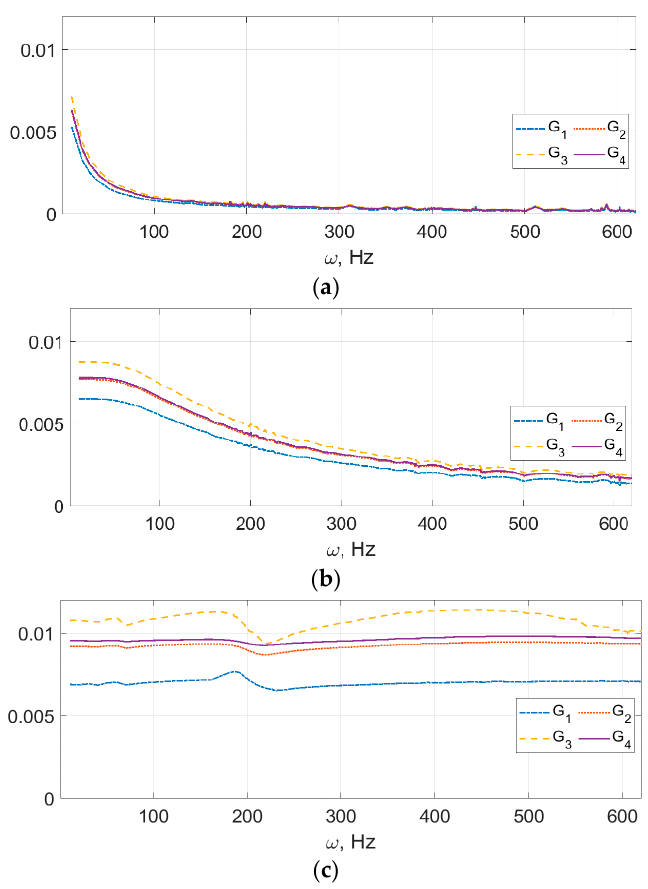
Figure 11. Frequency responses for different damping. ( a ) A forced g for damping coefficient b 1 (mm); ( b ) A forced g for damping coefficient b 2 < b 1 (mm); and ( c ) A forced g for damping coefficient b 3 < b 2 < b 1 (mm).